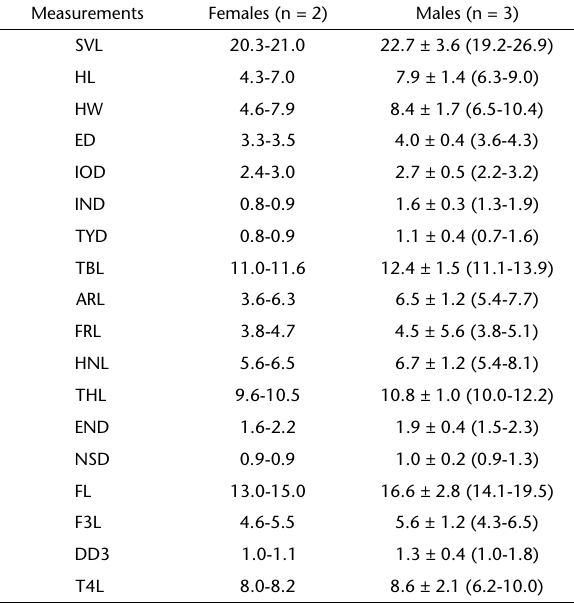
Table I. Measurements (in millimeters) of Fritziana ulei . Abbreviations of the measurements are defined in the Material and Methods. The mean ± standard deviation is followed by the (range).